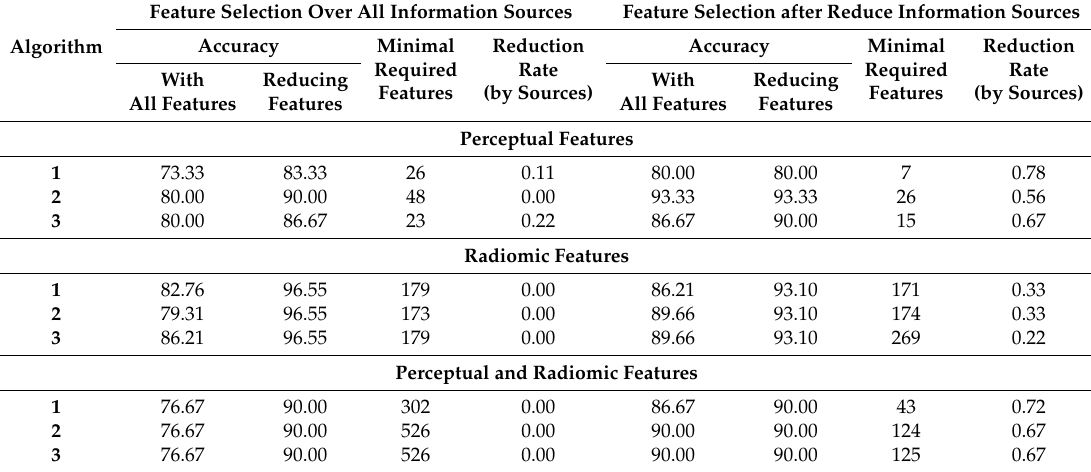
Table 9. Comparison of results applying feature selection by Fisher Score technique over the MRI data before and after the source reduction